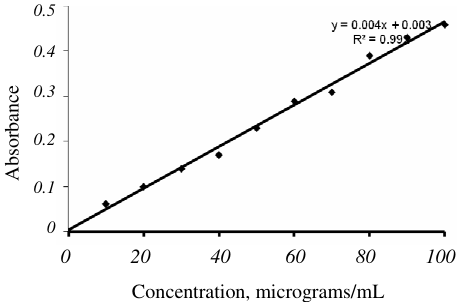
Figure 1. Calibration curve (Method A)